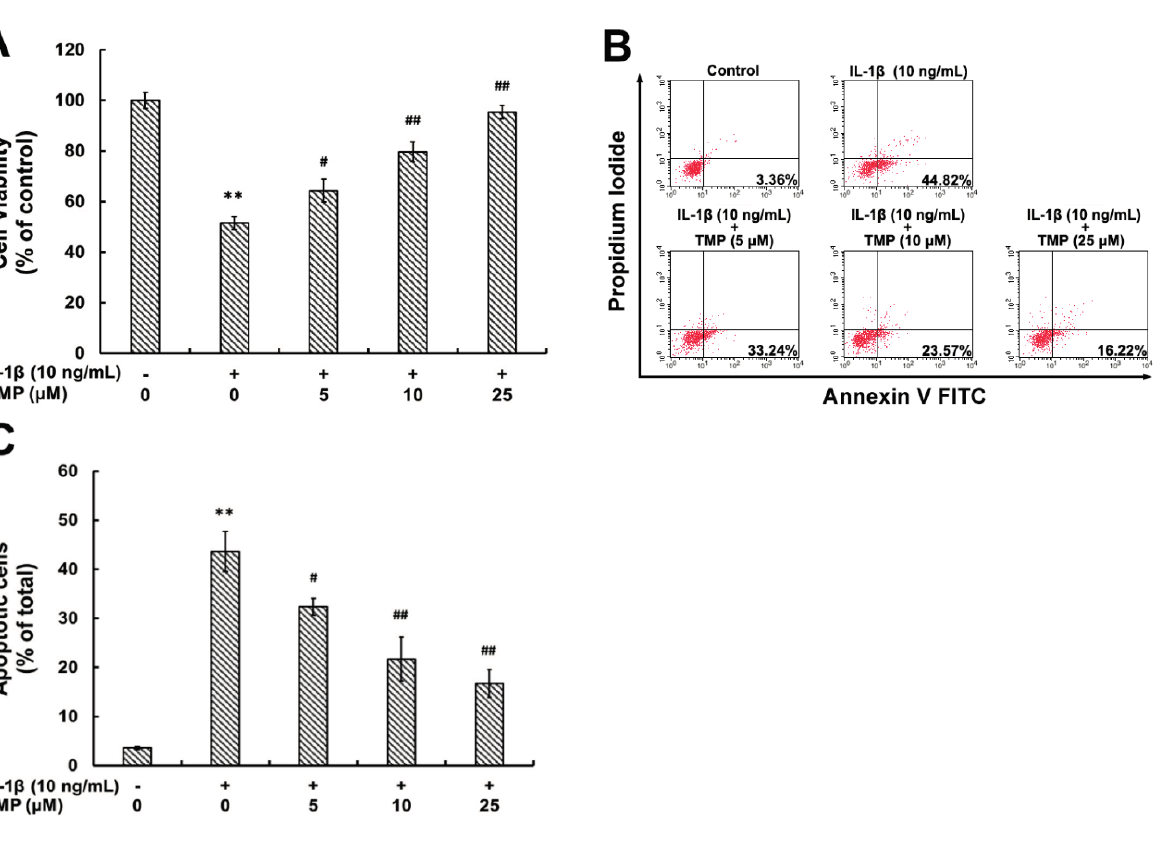
Figure 5. Effect of TMP on IL-1 β -induced cell injury and apoptosis in TR-iBRB2 cells. With the treatment of indicated drugs, cell viability was evaluated by MTT assay ( A ) and cell apoptosis was evaluated by the Annexin V-PI dual-staining assay ( B , C ). All data were expressed as mean ± SD of three experiments and each experiment included triplicate repeats. ** p < 0.01 vs. control group; # p < 0.05, ## p < 0.01 vs. IL-1 β -treated